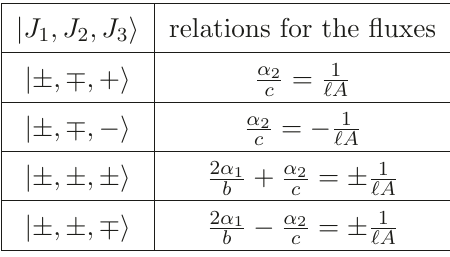
Table 10 . Decomposition of (5.24) into